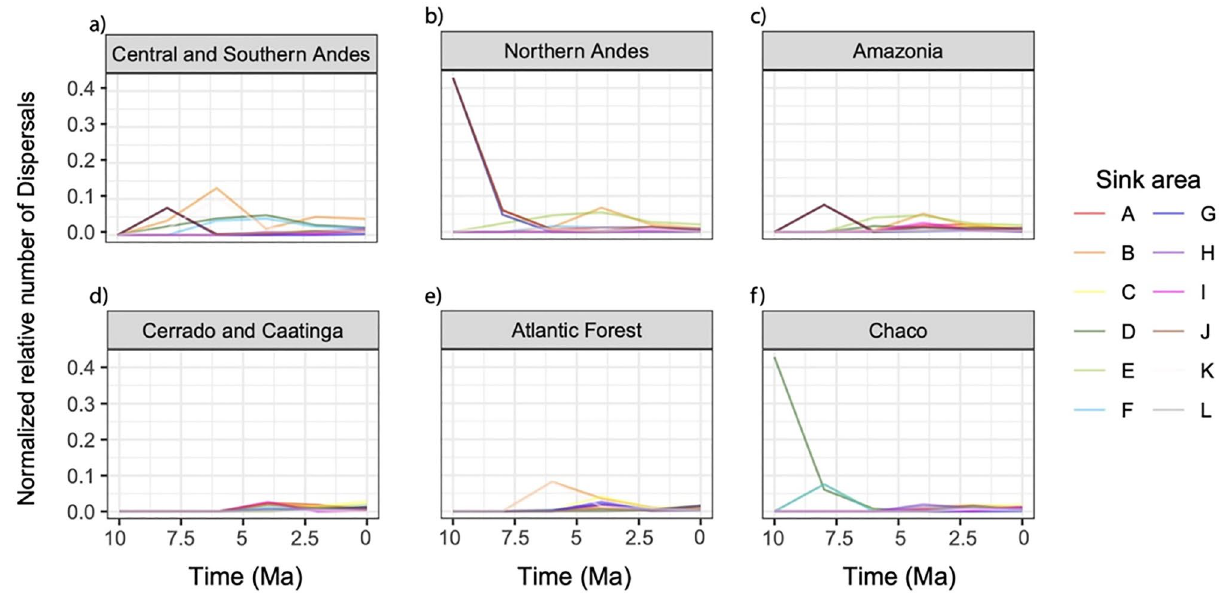
Figure 5. Colonization rates through time (relative number of dispersal events by dividing absolute numbers by the total length of all branches within each 2 Ma time bin) for the six main source regions (Table 1). Source regions (dispersal from) follow the colours in the key sink regions (dispersal to). See figure legend 3 for the names and detail of the biogeographic